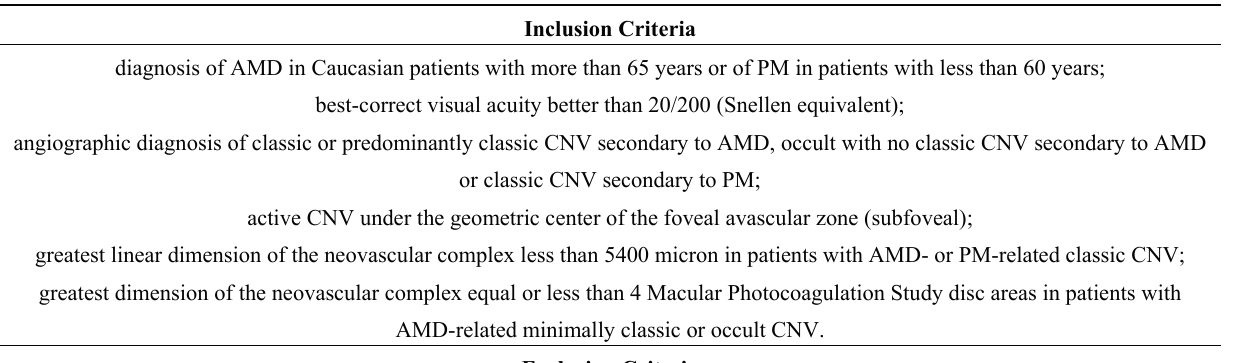
Table 3. Inclusion and exclusion